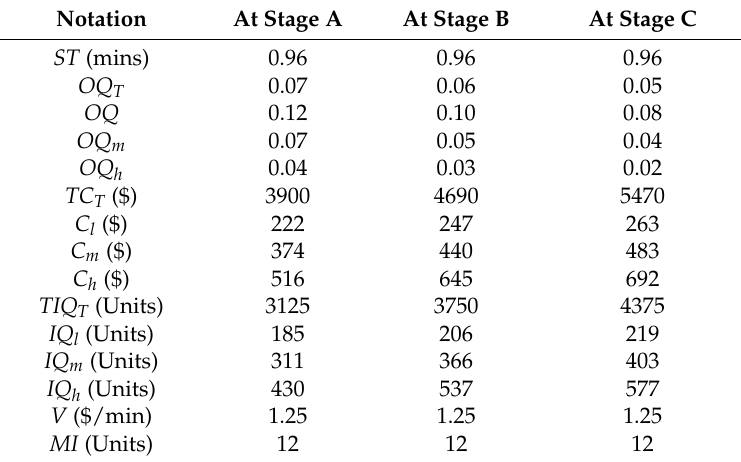
Table 2. Input data for short sleeve polo